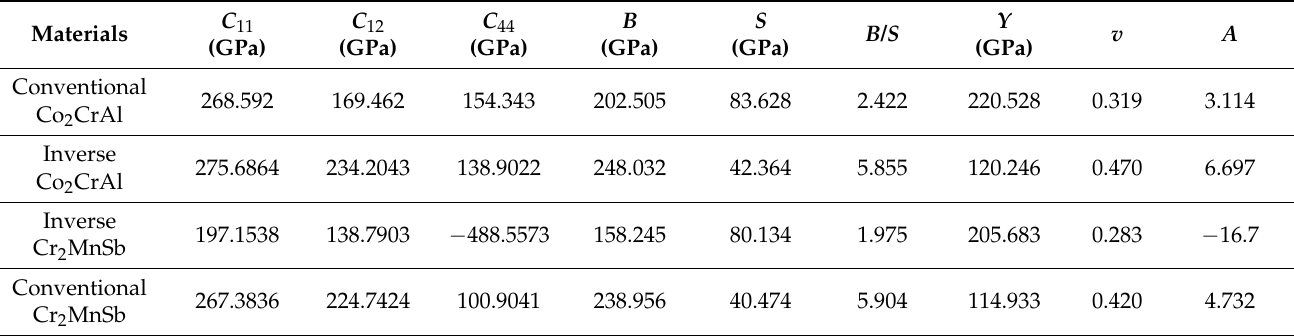
Table 8. Reuss’s bulk modulus ( B ), shear modulus ( S ), elastic constants ( C ij ), B/S ratio, Poisson’s ratio ( v ), Young’s modulus ( Y ) and anisotropic factor ( A ) of the FM conventional and inverse Heusler (Co 2 CrAl, Cr 2 MnSb)